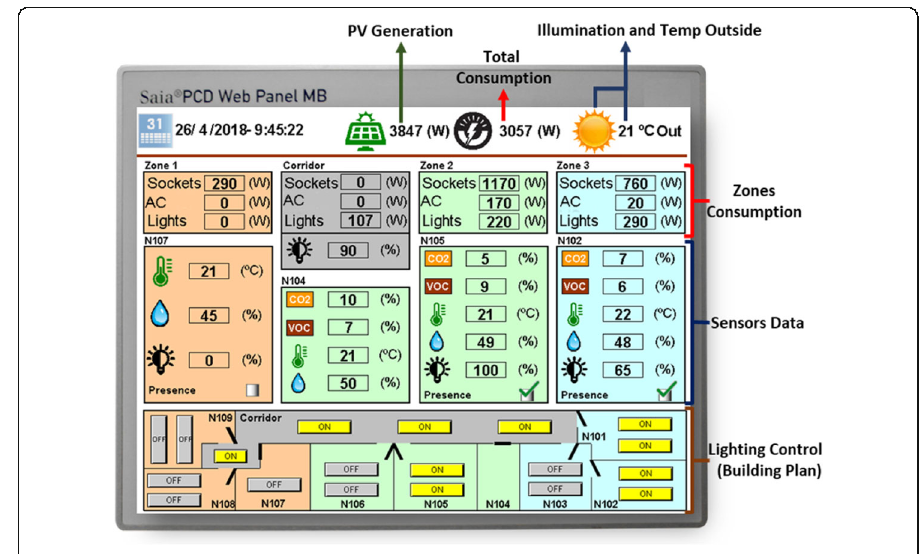
Fig. 2 Designed webpage for monitoring real-time data of SCADA (touch screen